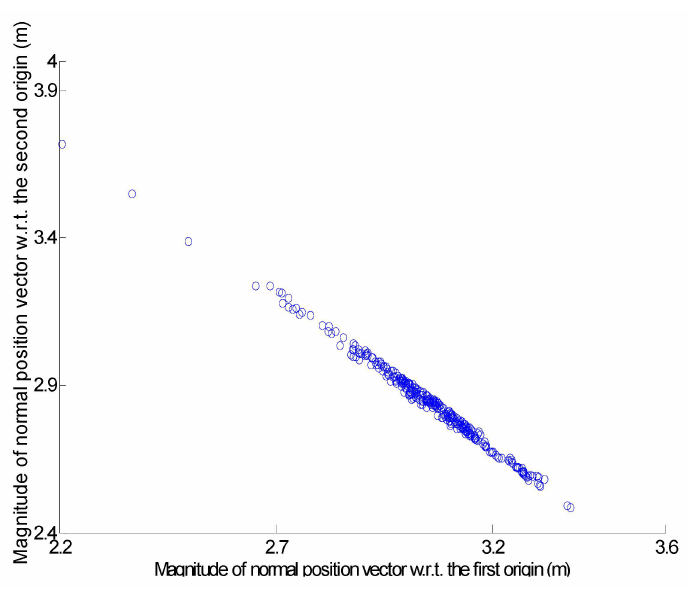
Figure 9. Scatter plot prior to resolution of ambiguity problem.